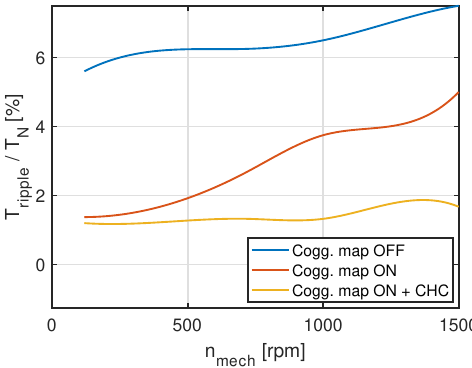
Figure 17. Peak value of torque ripple vs. mechanical speed.